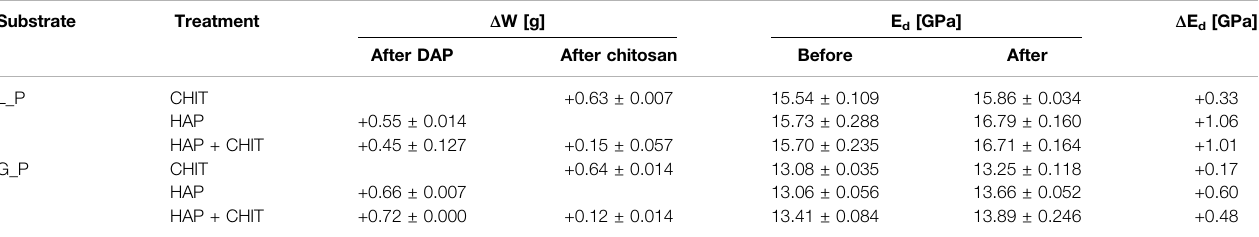
TABLE 2 | Characteristics of prismatic samples: mass variation after treatment in dry condition ( Δ W), dynamic elastic modulus before and after treatment (E d ), variation of dynamic elastic modulus ( Δ E d ).